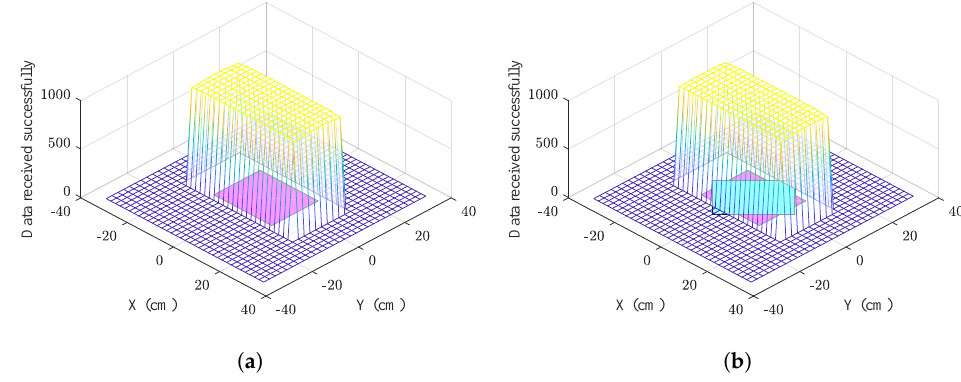
Figure 12. Data successfully received underwater. ( a ) Coils aligned. ( b ) Coils rotated